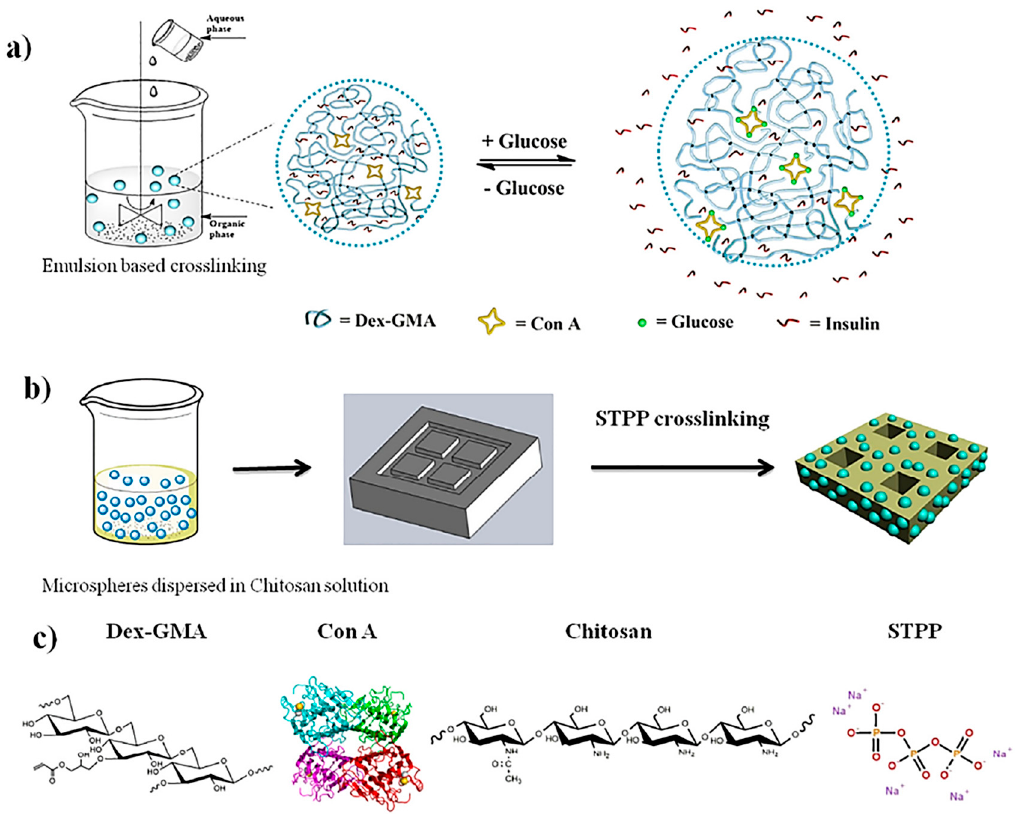
Figure 2. ( a ) Schematic process of fabricating ConA microspheres via w / o emulsion-based crosslinking, ( b ) preparation of the chitosan-based scaffolds for insulin delivery, and ( c ) chemical structures of dextran glycidyl methacrylate (Dex-GMA), concanavalin-A (ConA), chitosan, and sodium tripolyphosphate (STPP) (reproduced with permission from Reference [49]).